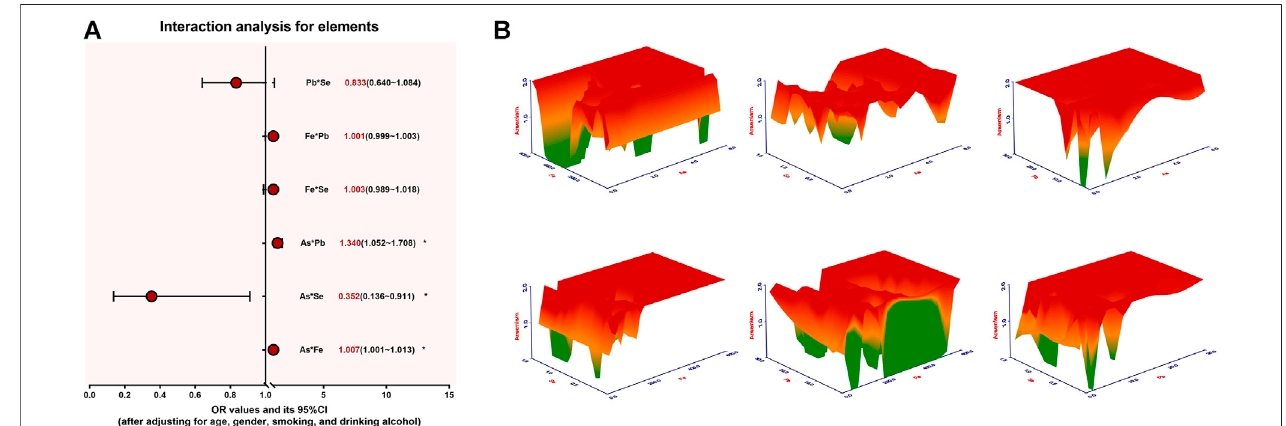
FIGURE 4 | The interaction between the content of As, Fe, Pb, and Se for arsenism, * p < 0.05. (A) The interaction analysis results of As, Fe, Pb, and Se and arsenism. (B) The dose – response relationship between the effects of As, Fe, Pb, and Se alone and their combination on the pathogenicity of arsenism. As the color changes from green to yellow and then to red, the pathogenicity of arsenism gradually increases.